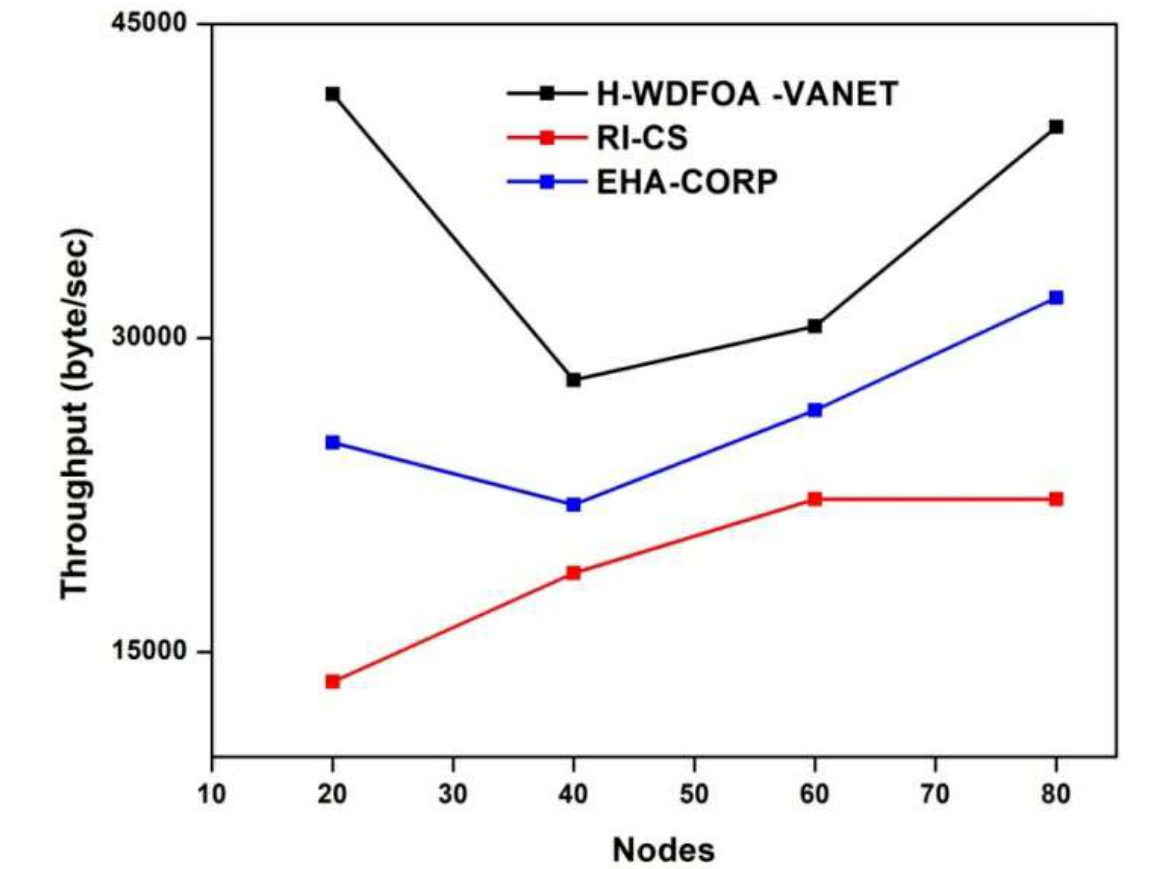
Figure 18. Plots of nodes vs. fairness index in the suggested approach and existing approaches.